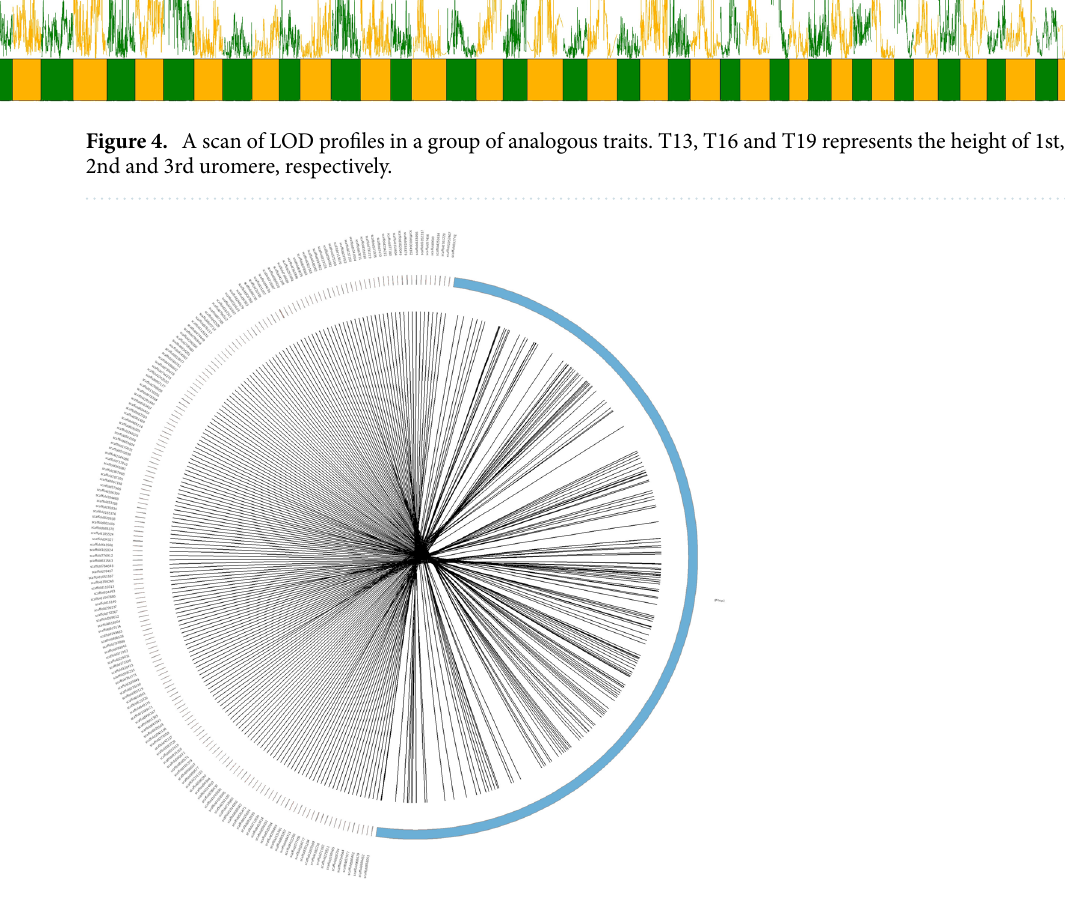
Figure 5. Circos demonstration of the integration of LG1 and genomic